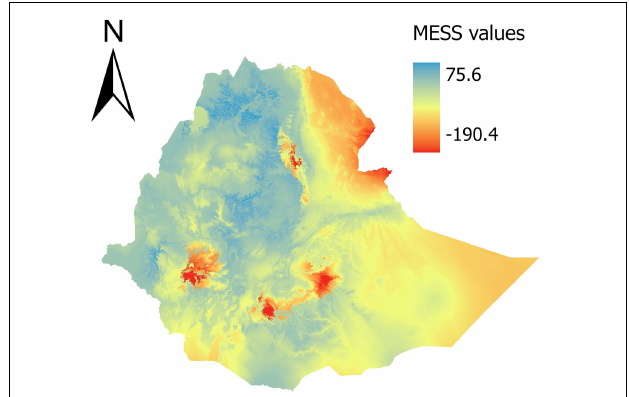
FIGURE 4 | MESS analysis. Negative MESS values showed by red colors have one or more predictors outside the range of present in the training data. Deeper red colors show larger differences and predictions here should be treated with strong caution.